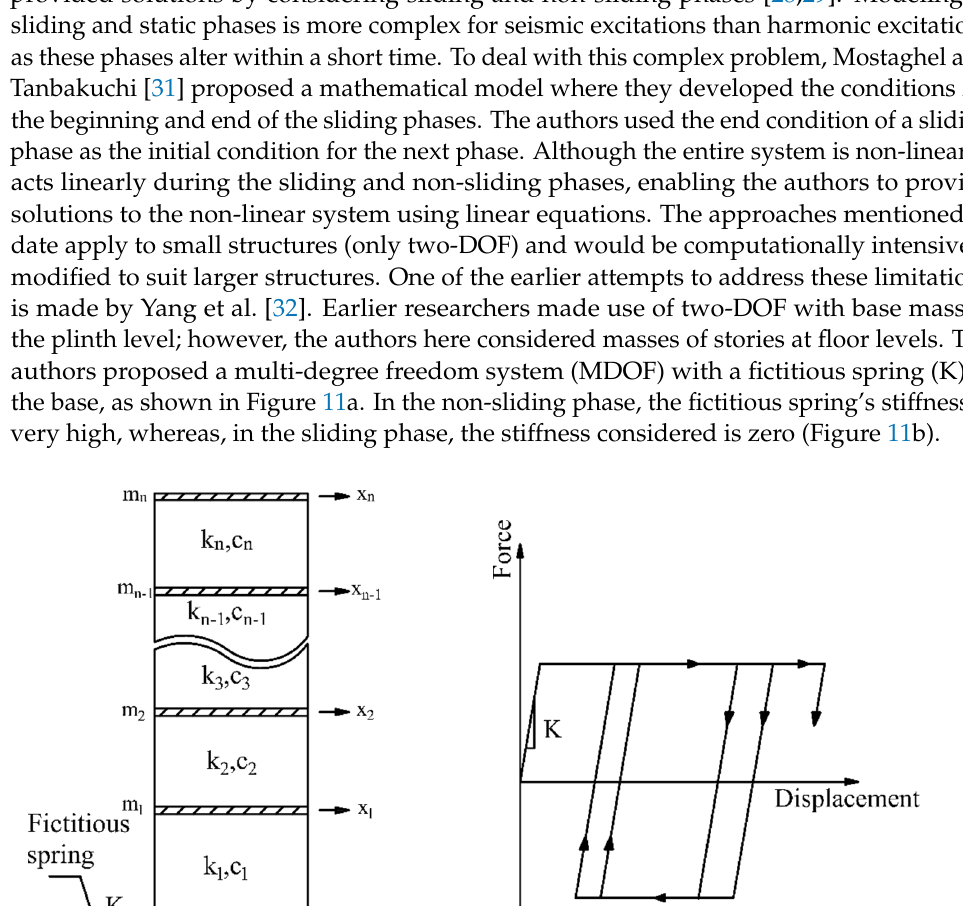
Figure 11. Structure considered by Yang et al. [32]. ( a ) MDOF system with fictitious spring, ( b ) force- displacement bbehavior of the spring.